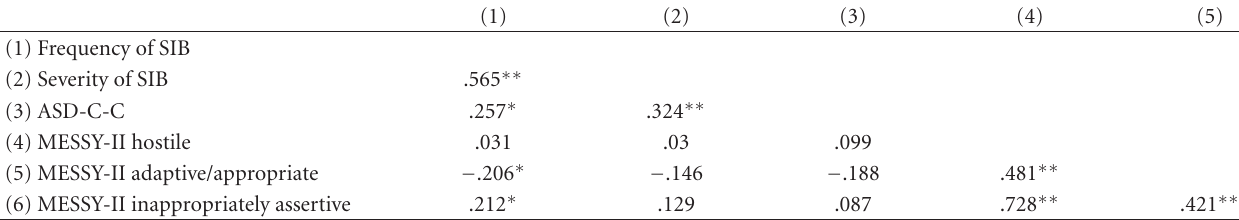
Table 1: Correlation matrix of manifest variables used in the structural equation model.